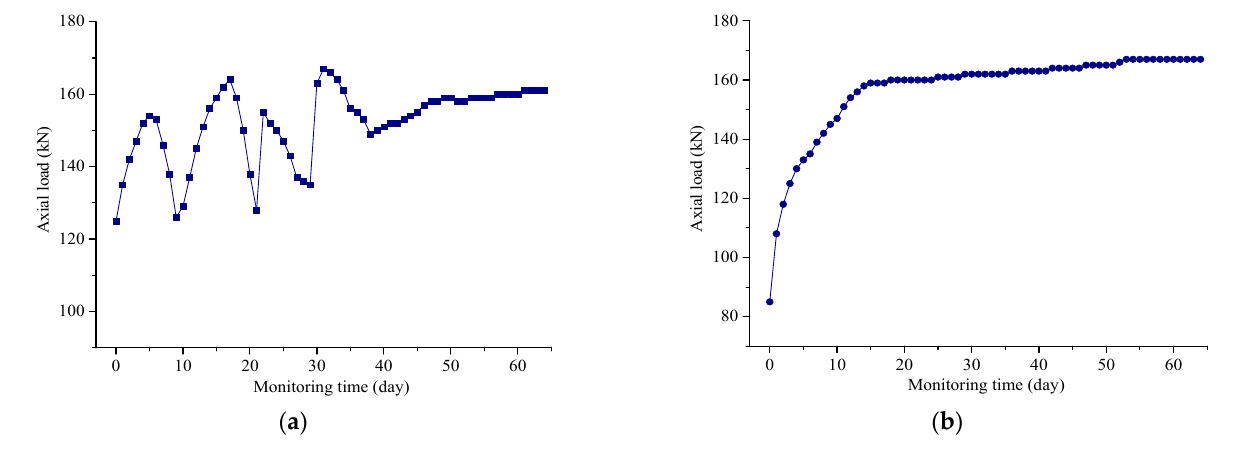
Figure 16. Curve of the working load on bolt/anchor cable under new support. ( a ) Arc roof; ( b ) Straight inclined roof.